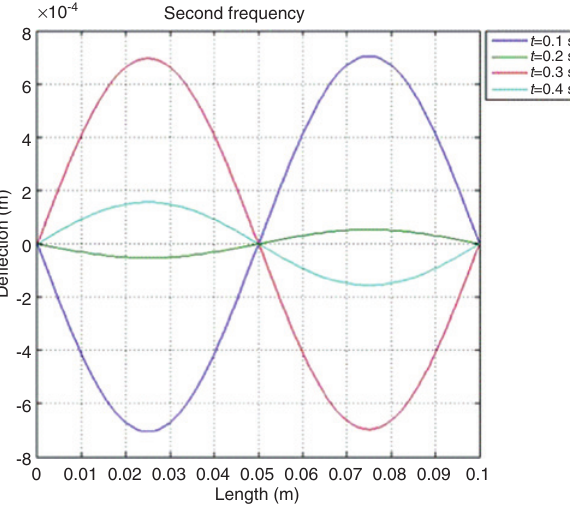
Figure 7: Vibrations of the second characteristic mode of the simply supported beam.